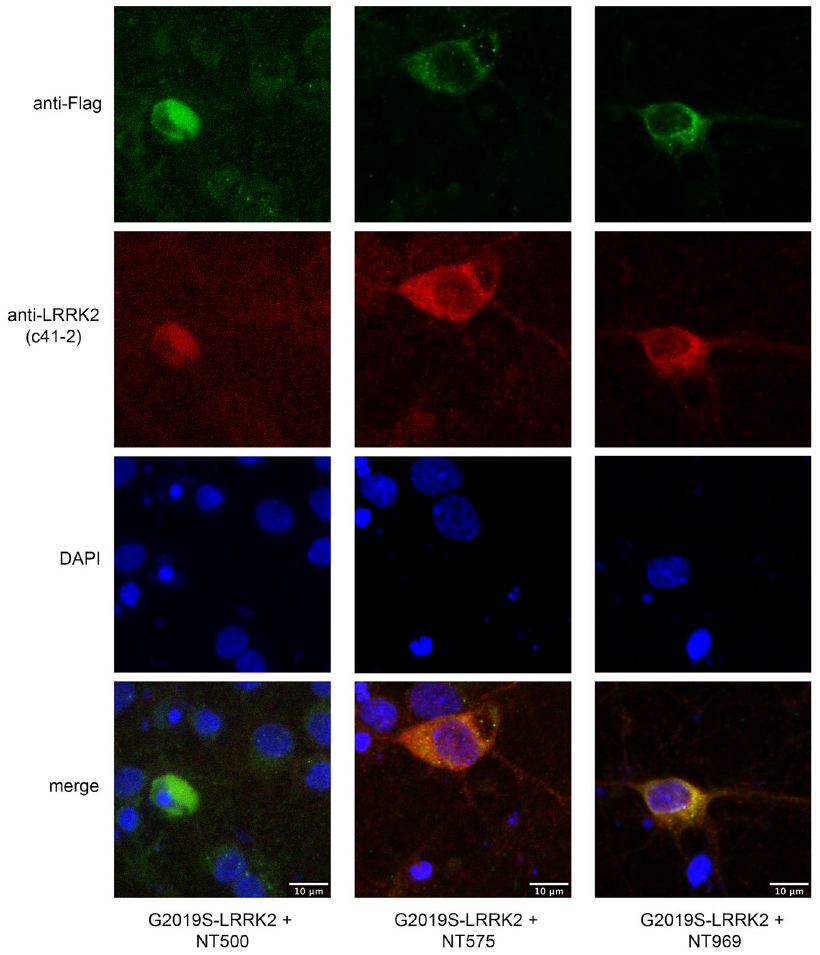
Figure 11. Fragments of LRRK2 ARM region are neuroprotective. Primary cortical neurons were transiently co-transfected with full-length untagged WT or G2019S mutant LRRK2 together with different Flag-tagged N-terminal fragments of LRRK2 depicted in the schematic shown in Fig. 10b. Fixed neurons were then processed for anti-Flag immunostaining to label the LRRK2 ARM fragment (NT500, NT575, or NT969), together with anti-LRRK2 (clone c41-2) to label full-length LRRK2. A representative image showing neurons expressing G2019S-LRRK2 together with the different ARM fragments is presented. Scale bar is 10 μ